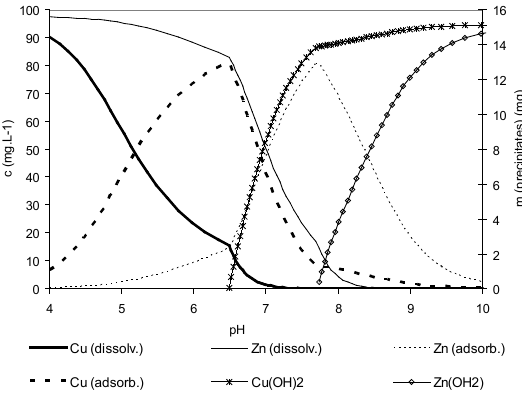
Figure 7. Results of calculation of the alkalization of mixture of water with activated carbon (100 mL, 1 g) with initial pH of 4 and initial concentration of both metals of 100 mg L -1 (using the model 2)